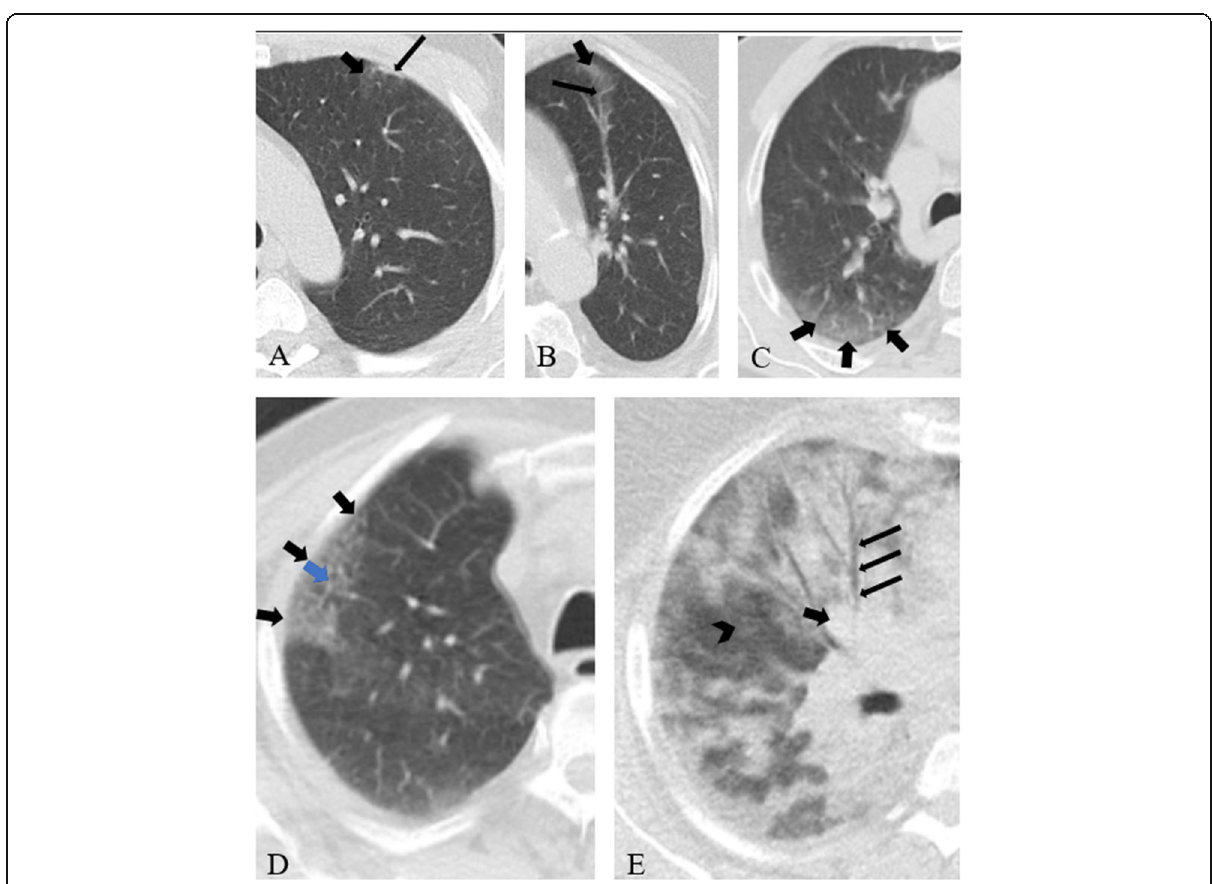
Fig. 1 Low-dose chest CT scan images in 5 different patients with RT-PCR-confirmed COVID-19 pneumonia, showing a variety of diseased lung extension and density, comparable with the standard-dose CT scan. a Peripheral area of ground-glass opacity (thick short arrow) with overlying pleural thickening (thin long arrow). b Mixed central-peripheral lesion of ground-glass opacity (thick short arrow) with a prominent intralesional vessel (thin long arrow). c Peripheral area of ground-glass opacity (black arrows) with prominent intralesional vessels. d Peripheral area of crazy paving pattern (black arrows) with thickened interlobular septa within (blue arrow). e Mixed ground-glass opacity (arrowhead) and consolidation (thick black arrow). Long thin arrows point out air-bronchogram [images are from first author ’ s institution, implementing low-dose CT scan protocol, with scanning parameters as follows: kVp 120, mAs 50, pitch factor 1, thickness 3